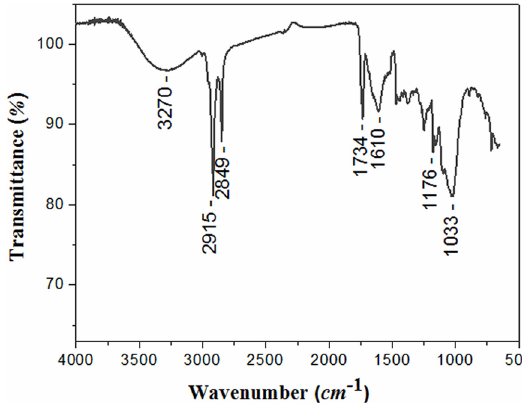
Figure 2. FTIR spectrum of the cocoa bean shell powder.